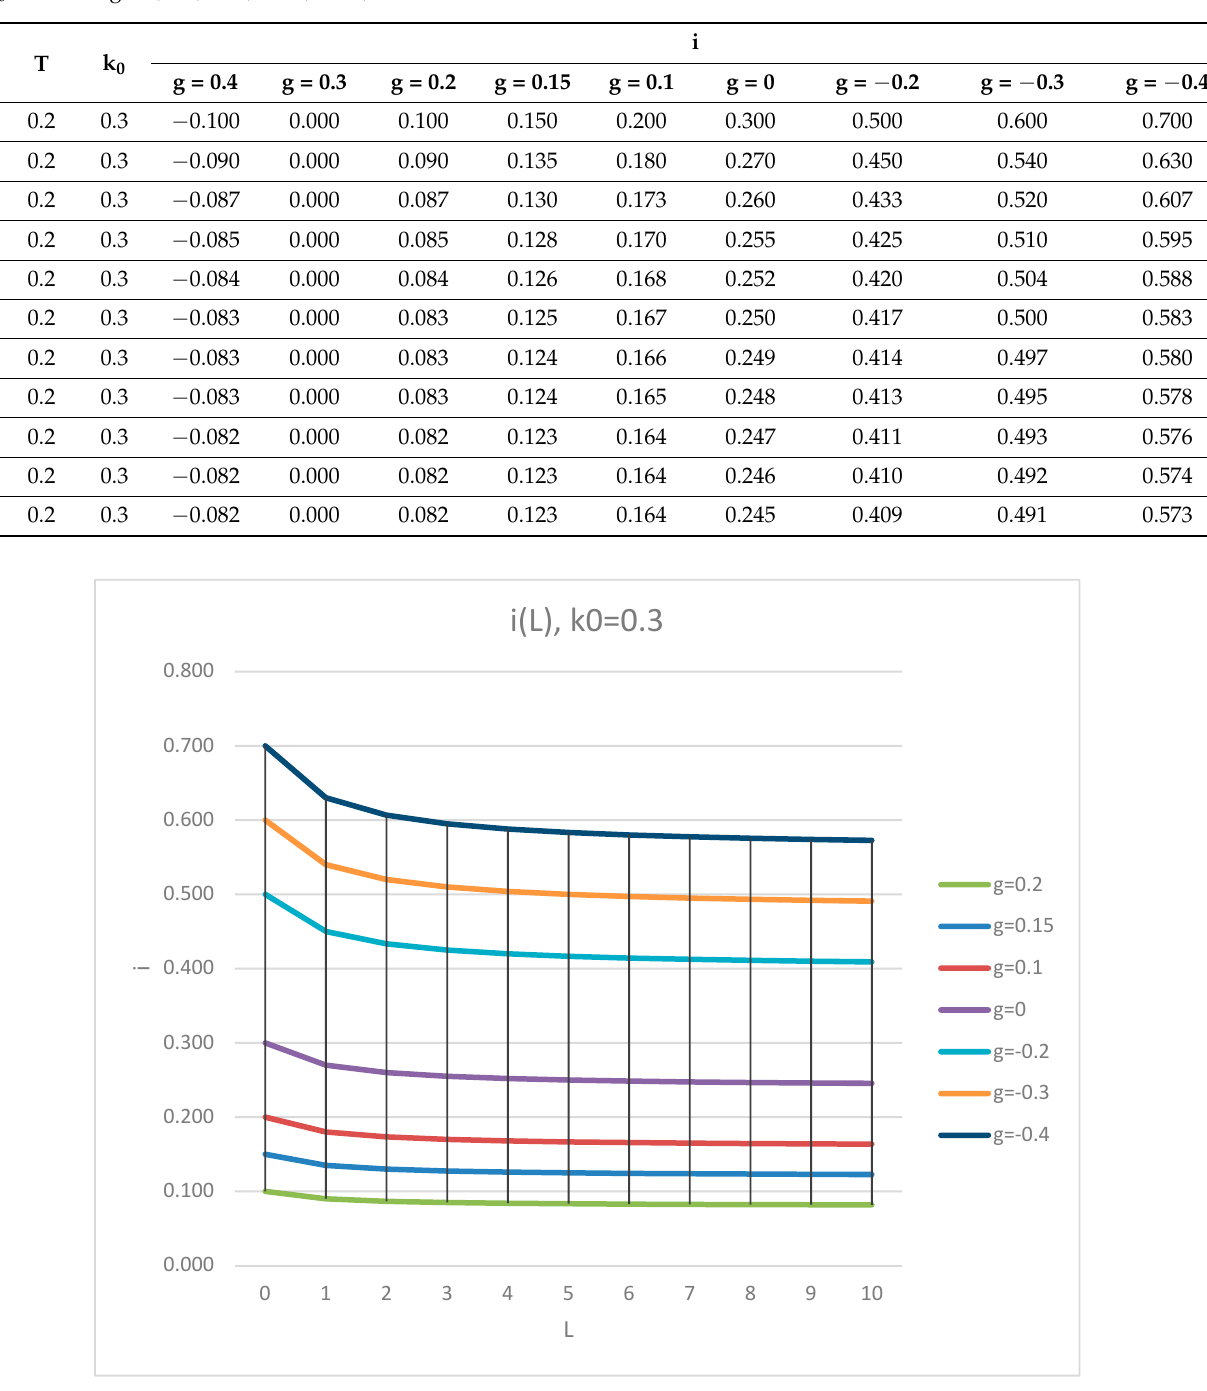
Figure 5. Dependence of discount rate i on leverage level L in Generalized Modigliani–Miller theory (GMM theory) at k 0 = 0.3 and g = 0; 0.1; 0.15; ± 0.2; − 0.3; − 0.4.